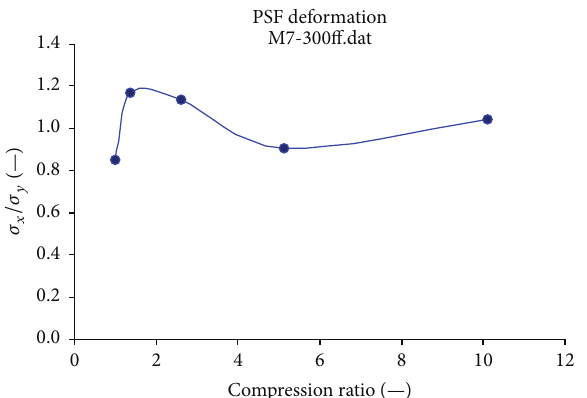
Figure 11: Point spread function deformation (i.e., ellipticity) as a function of the compression ratio (wide field image).